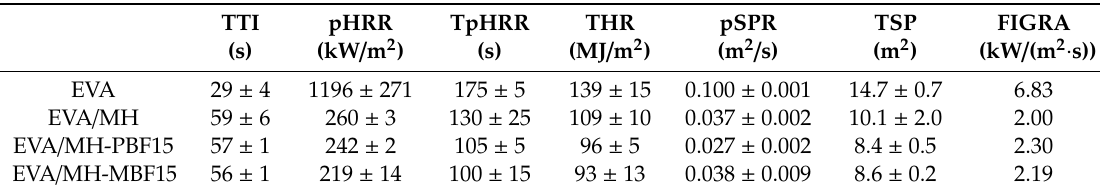
Table 2. CCT Data of EVA and EVA